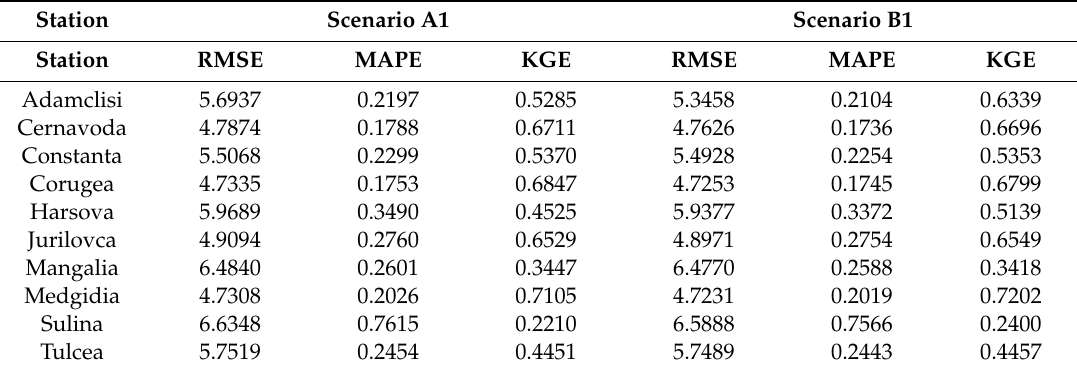
Table 8. Mean Absolute Percentage Error (MAPE) values for the predictions computed with OIDW for the series recorded at all the meteorological stations in the scenarios A1 and